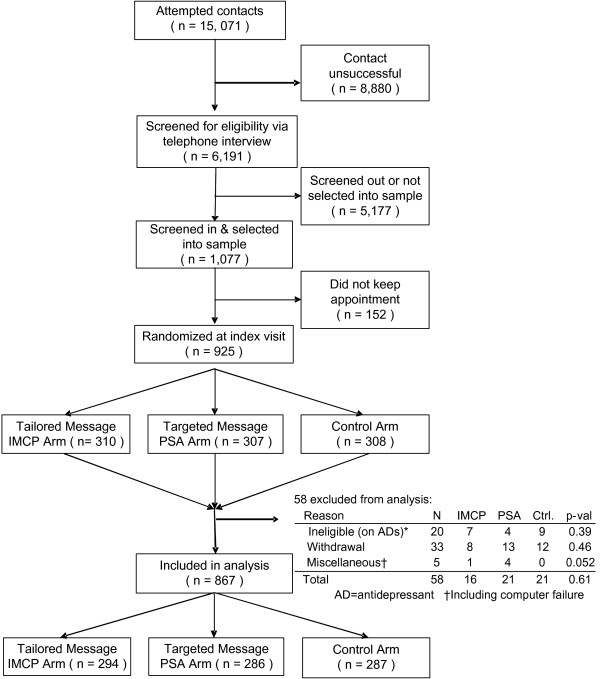
CONSORT diagram.